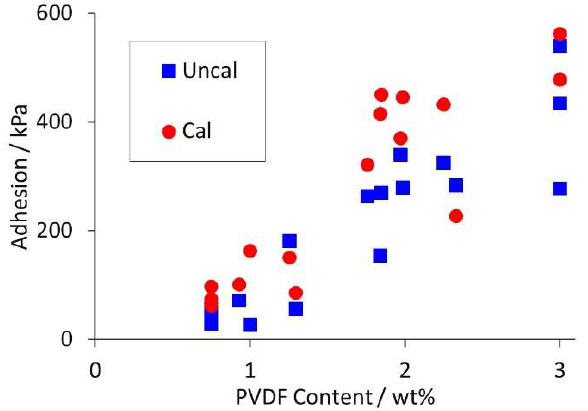
Figure 2. Variation in adhesion with PVDF content in mix (uncalendered and calendered).